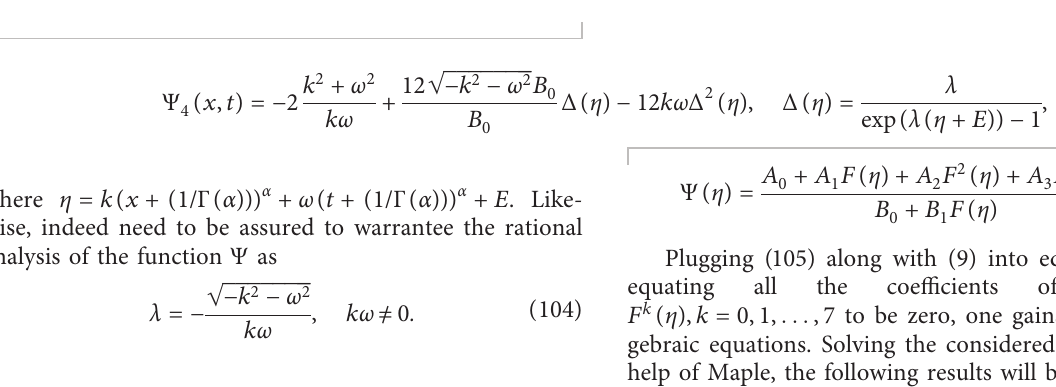
( x, t ) at A � 1 ,B � 2 ,a � 3 ,b � 2 ,k � 1 . 5 , ω � 2 , β � 3 , c � − 1 , and α � 1 for (a) 3D plot and (b) and (c) 2D 2 0 0